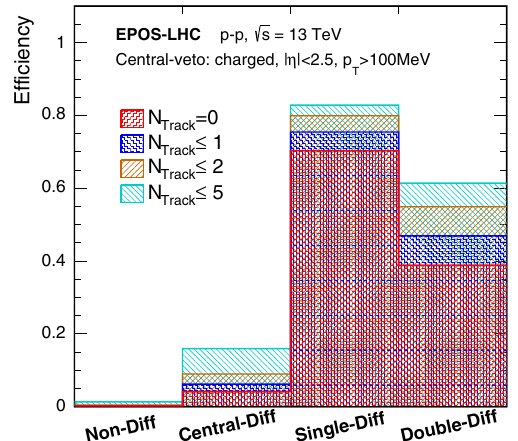
Fig. 6 Diffraction selection efficiency with different central-veto selection conditions: N track = 0 ( red ), N track ≤ 1 ( blue ), N track ≤ 2 ( brown ), and N track ≤ 5 ( cyan ) charged particles at | η | < 2 . 5